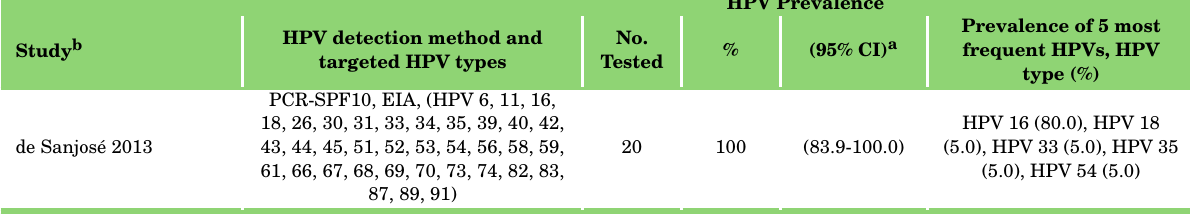
Table 28: Studies on HPV prevalence among VIN 2/3 cases in India